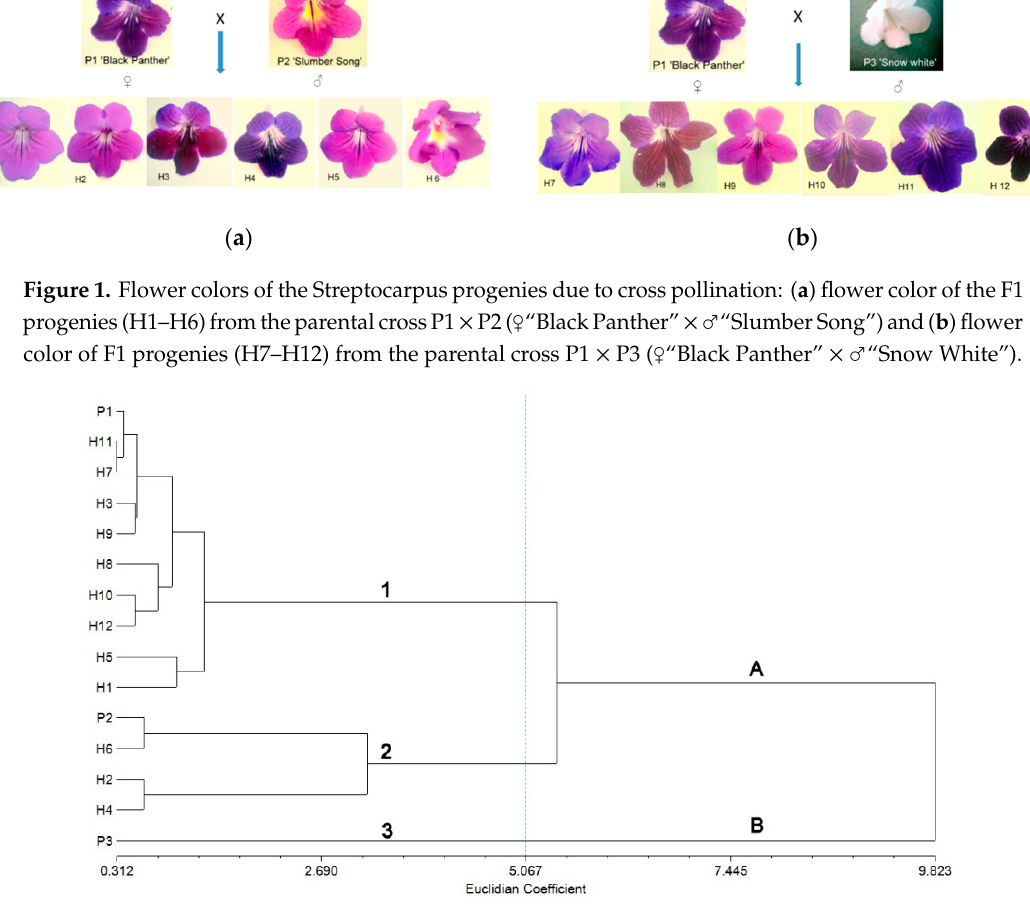
Table 2. List of SRAP primer pairs and the number of scored bands used in Streptocarpus.